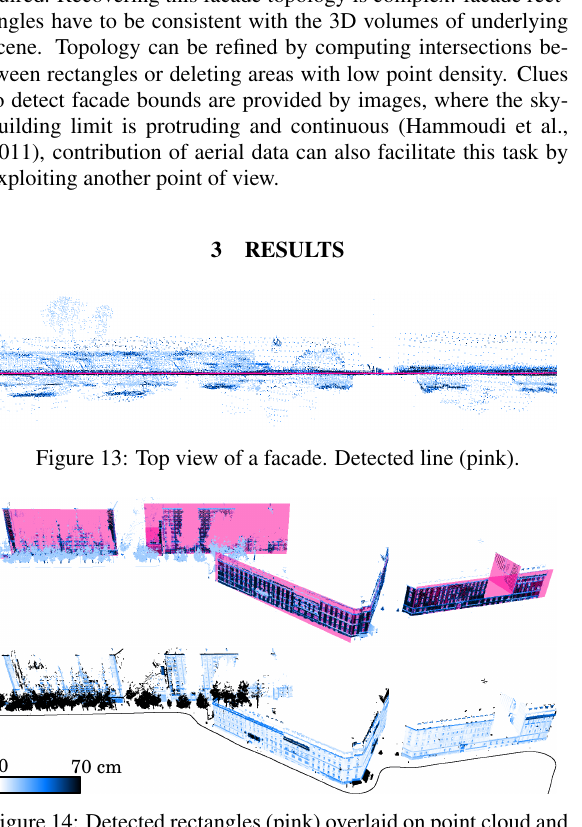
Figure 14: Detected rectangles (pink) overlaid on point cloud and orthogonal distance to the closest